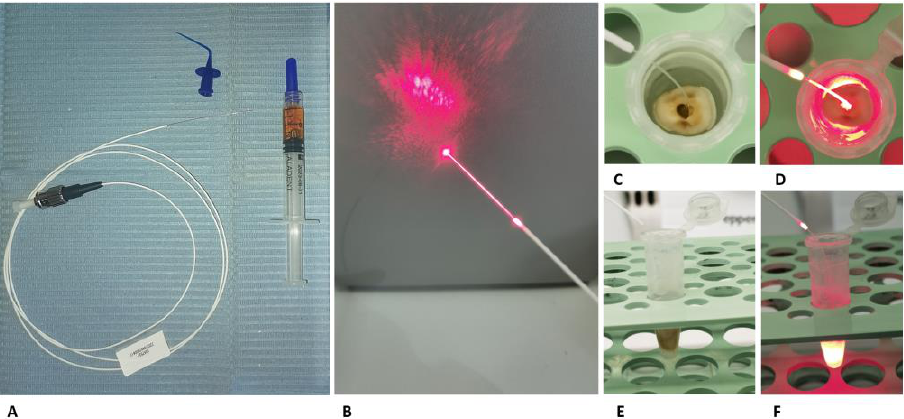
Figure 3. ( A ) The optical fiber used for ALAD-PDT, the tip to deliver the ALAD gel inside the canal roots, and the ALAD syringe. ( B ) The tip of the optical fiber during light irradiation. ( C ) and ( E ): occlusal and lateral view of the optical fiber inside the root canal, respectively. ( D ) and ( F ): occlusal and lateral view of the optical fiber inside the root canal during the light irradiation, respectively .